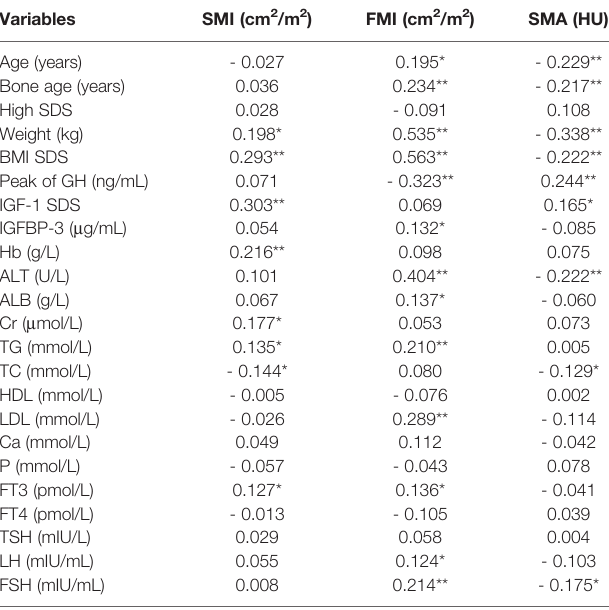
TABLE 2 | Correlations between body composition evaluated by T4 CT scan and clinical factors. Variables